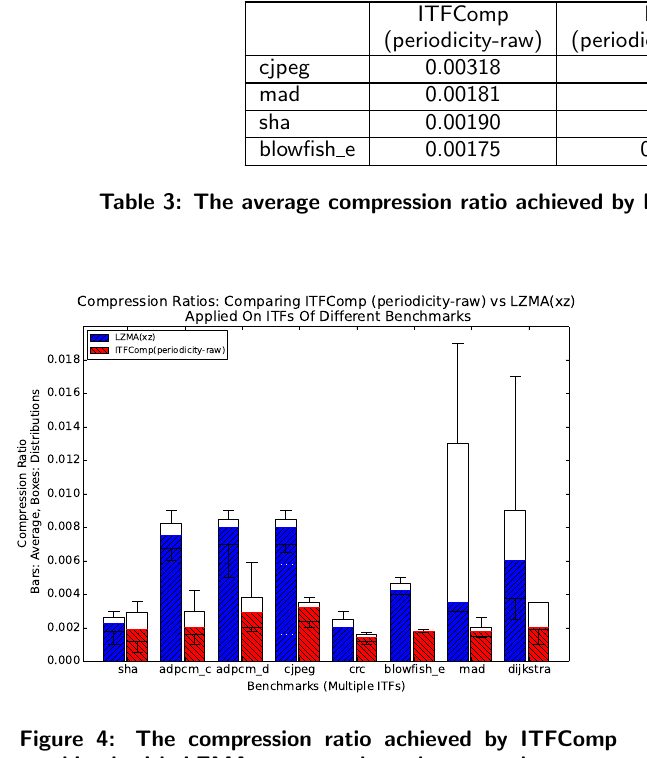
Figure 4: The compression ratio achieved by ITFComp combined with LZMA, compared to the general purpose compression algorithm LZMA(xz).